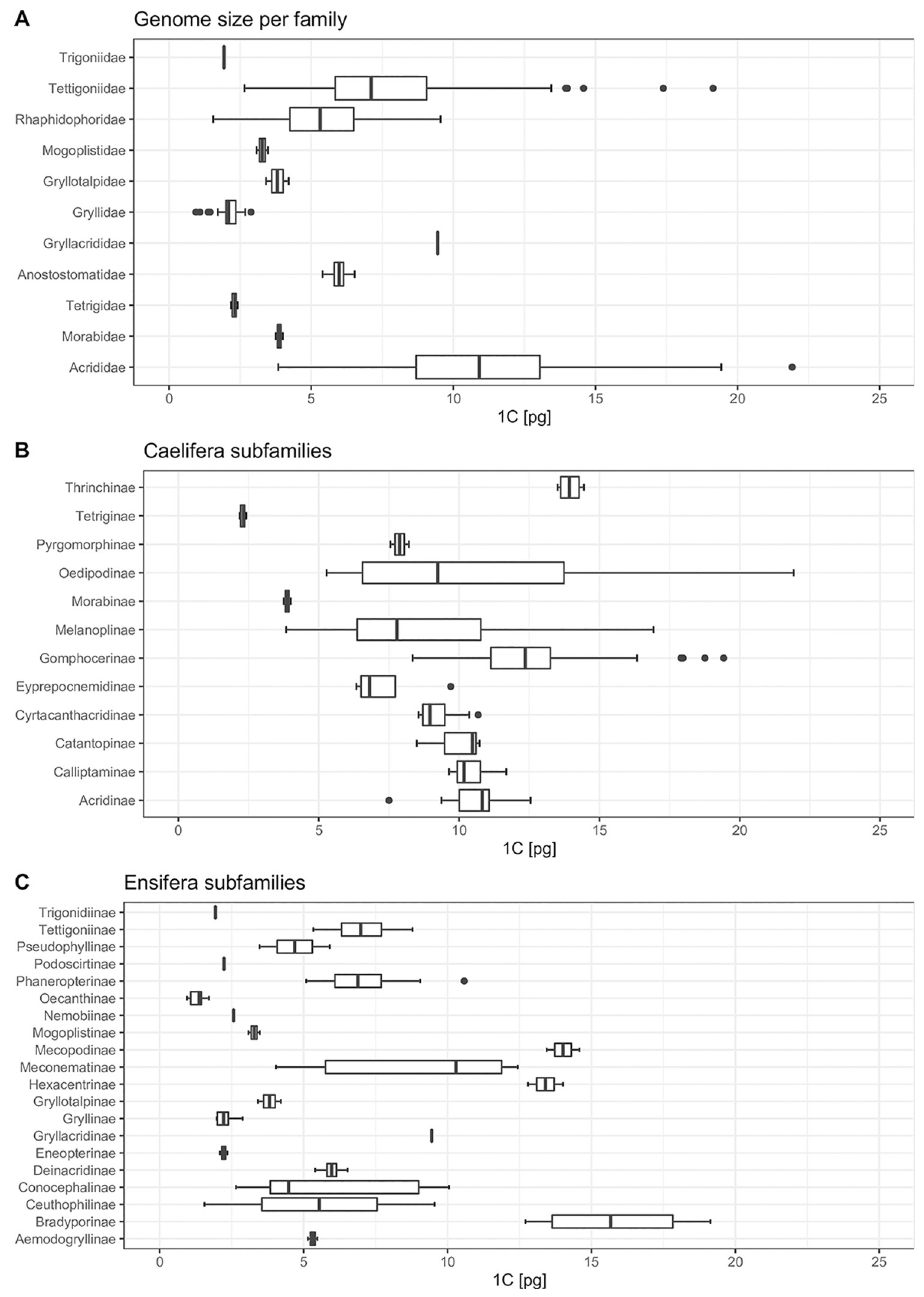
Fig 4. Box plots of genome size in families of Orthoptera (A), in subfamilies of Caelifera (B) and Ensifera